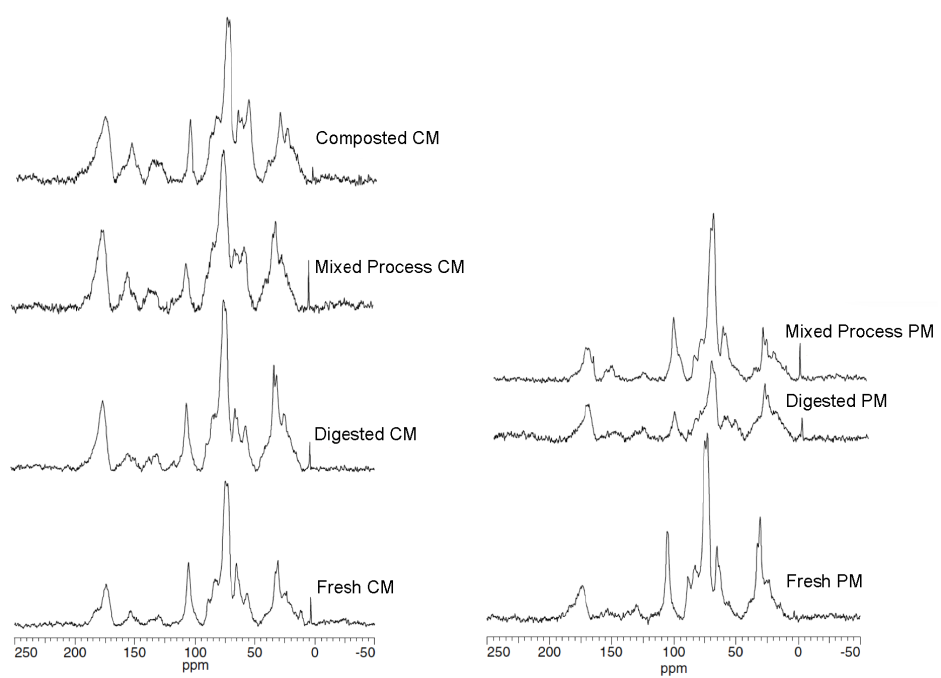
Figure 7. 13 C CP-MAS NMR spectra of CM ( left ) and PM ( right ) before and after anaerobic digestion, composting, and a mixed aerobic–anaerobic process. Adapted from Ref. [124].